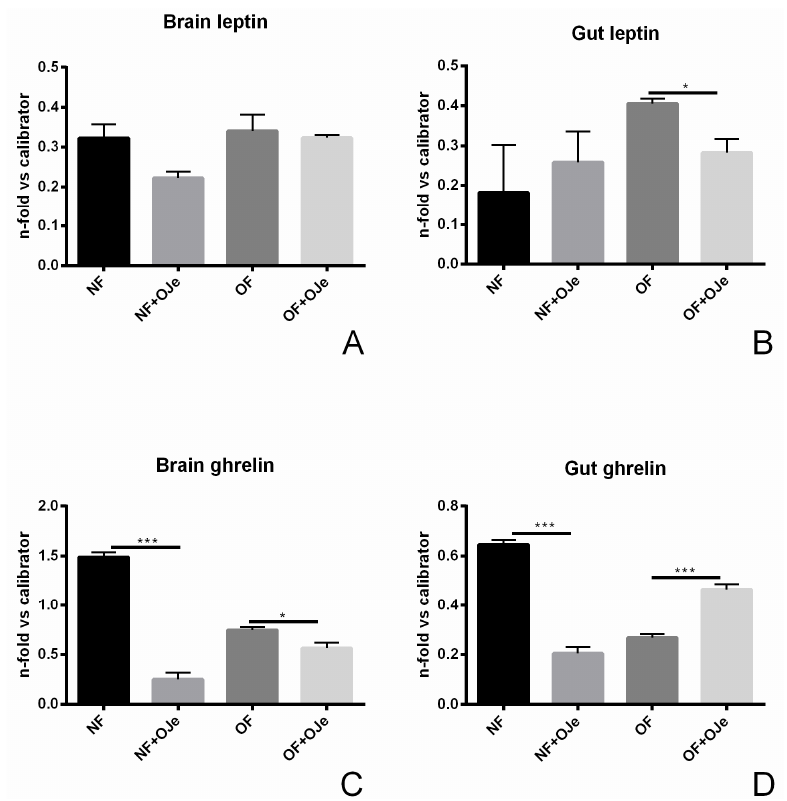
Figure 5. Effects of OJe on the expression of obesity-related genes. The expression of leptin A ( A , B ) and ghrelin ( C , D ) was evaluated by qPCR in both brains ( A , C ) and guts ( B , D ). Relative quantities of mRNA were calculated using the 2 −ΔΔ C t quantification method. Results are expressed as fold change in OJe-treated fish compared to untreated ones, after normalization to β -actin. Data represent the mean ± SD of five animals for each group. * p < 0.05, ** p < 0.01, *** p < 0.001 vs respective counterparts.